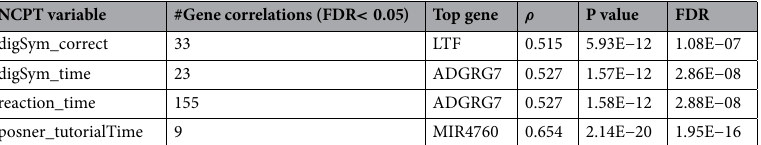
Table 1. Pearson correlation ρ between genes and 4 of the 5 top NCPT variables in Fig. 1c. Trail-time had no significant gene correlations (Fisher test at FDR 0.05) and is not shown. LTF (Lactotransferrin) is a Protein Coding gene that has been reported to stimulate the TLR4 signaling pathway leading to NF-kappa-B activation and subsequent pro-inflammatory cytokine production 8 . ADGRG7 (Adhesion G Protein-Coupled Receptor G7) is a Protein Coding gene that is found primarily in the intestine, but also in brain, cortex and cerebellum tissues 9 . MIR4760 is a miRNA with unknown function expressed in the brain and cortex 9 .